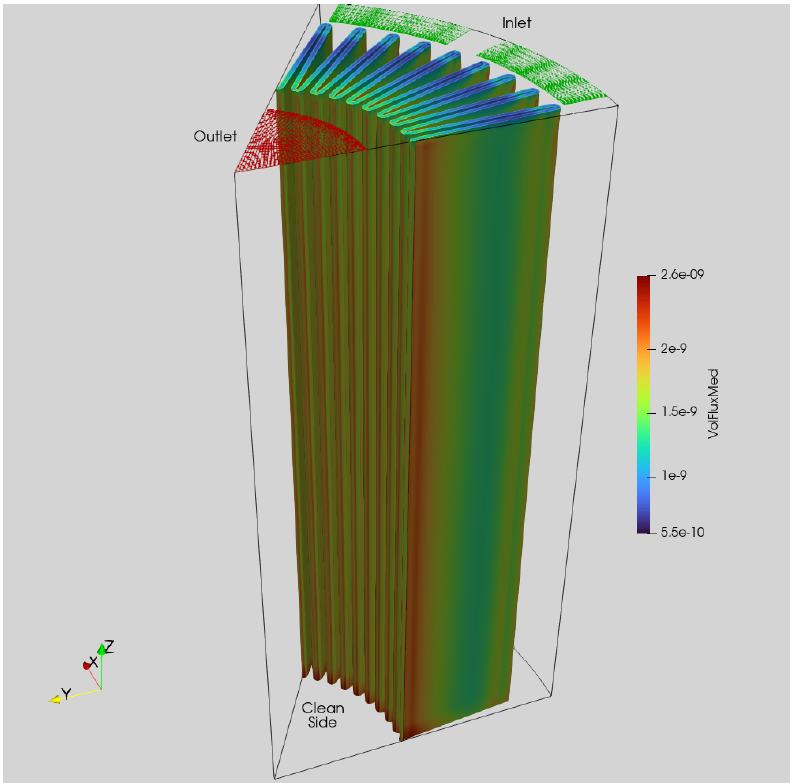
Figure 6. Flux of particle mass for particles with medium-sized diameter (30 ≤ d ≤ 40 µ